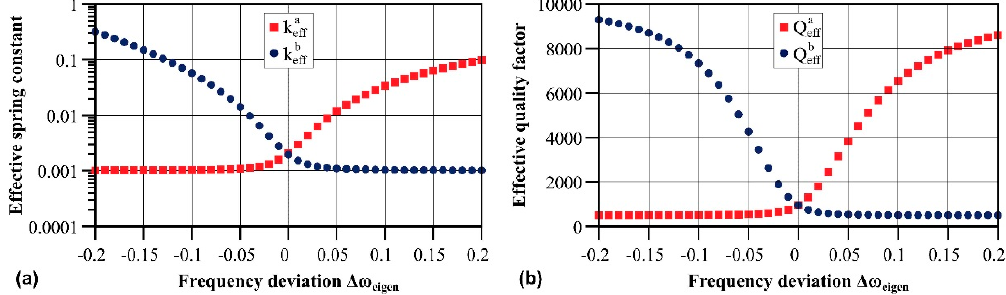
Figure 2. ( a ) Effective spring constant 𝑘 𝑒𝑓𝑓𝑎,𝑏 and ( b ) effective quality factor 𝑄 𝑒𝑓𝑓𝑎,𝑏 for left (index a, lower frequency) and right (index b, higher frequency) resonance peak of the co-resonantly coupled system with exemplary parameters from Table 1. Please note that the y-axis in ( a ) has logarithmic spacing for better